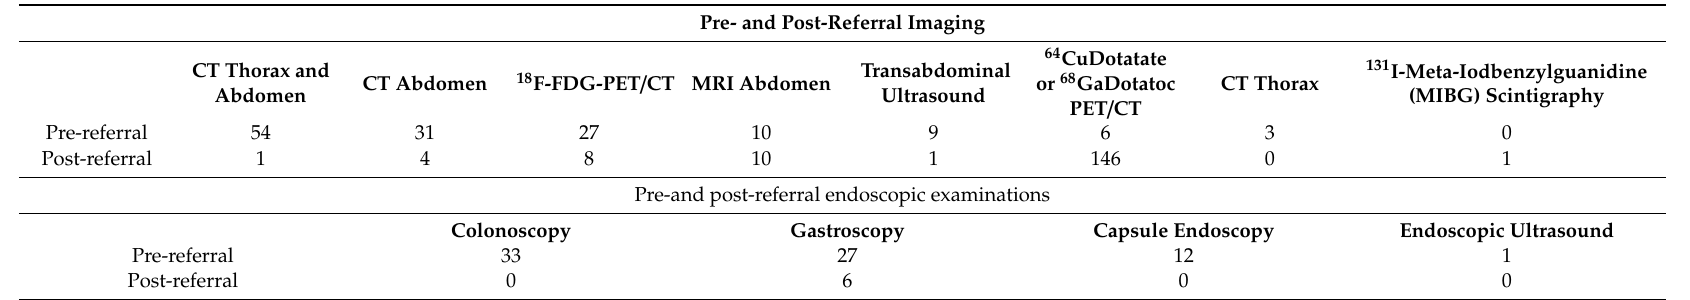
Table 2. Imaging and endoscopic examinations pre-and